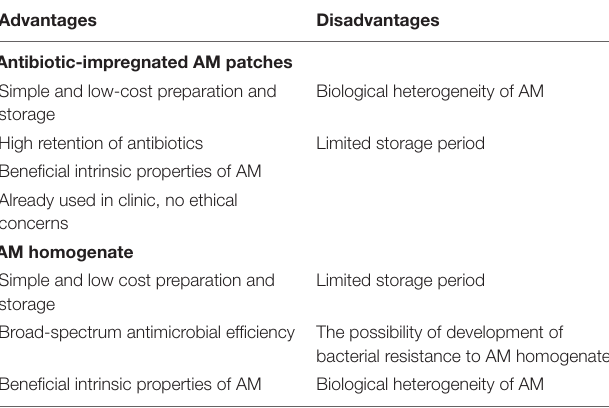
TABLE 2 | Overview of the advantages and disadvantages of the use of antibiotic-impregnated AM patches and AM